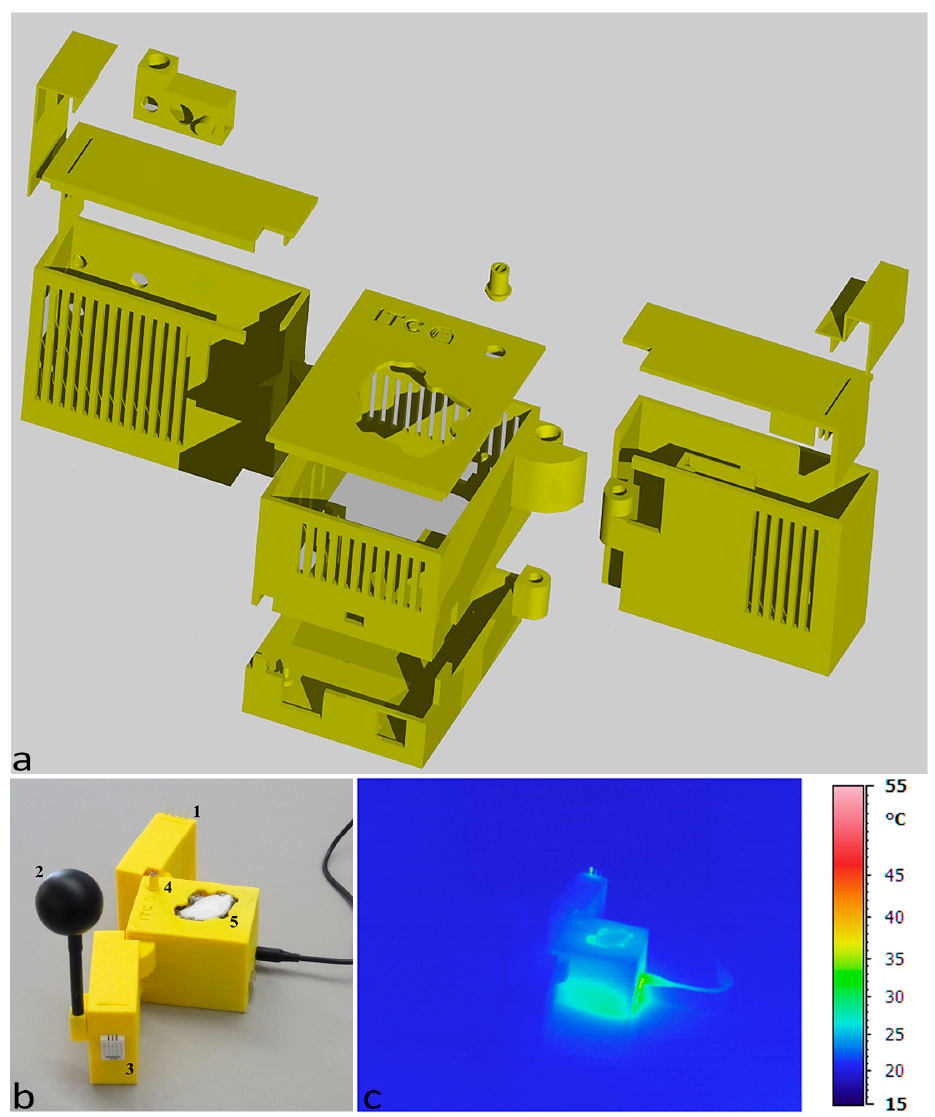
Figure 9. nEMoS case: ( a ) assembling scheme; ( b ) arrangement of sensors; and ( c ) thermal imaging after 24 hours.